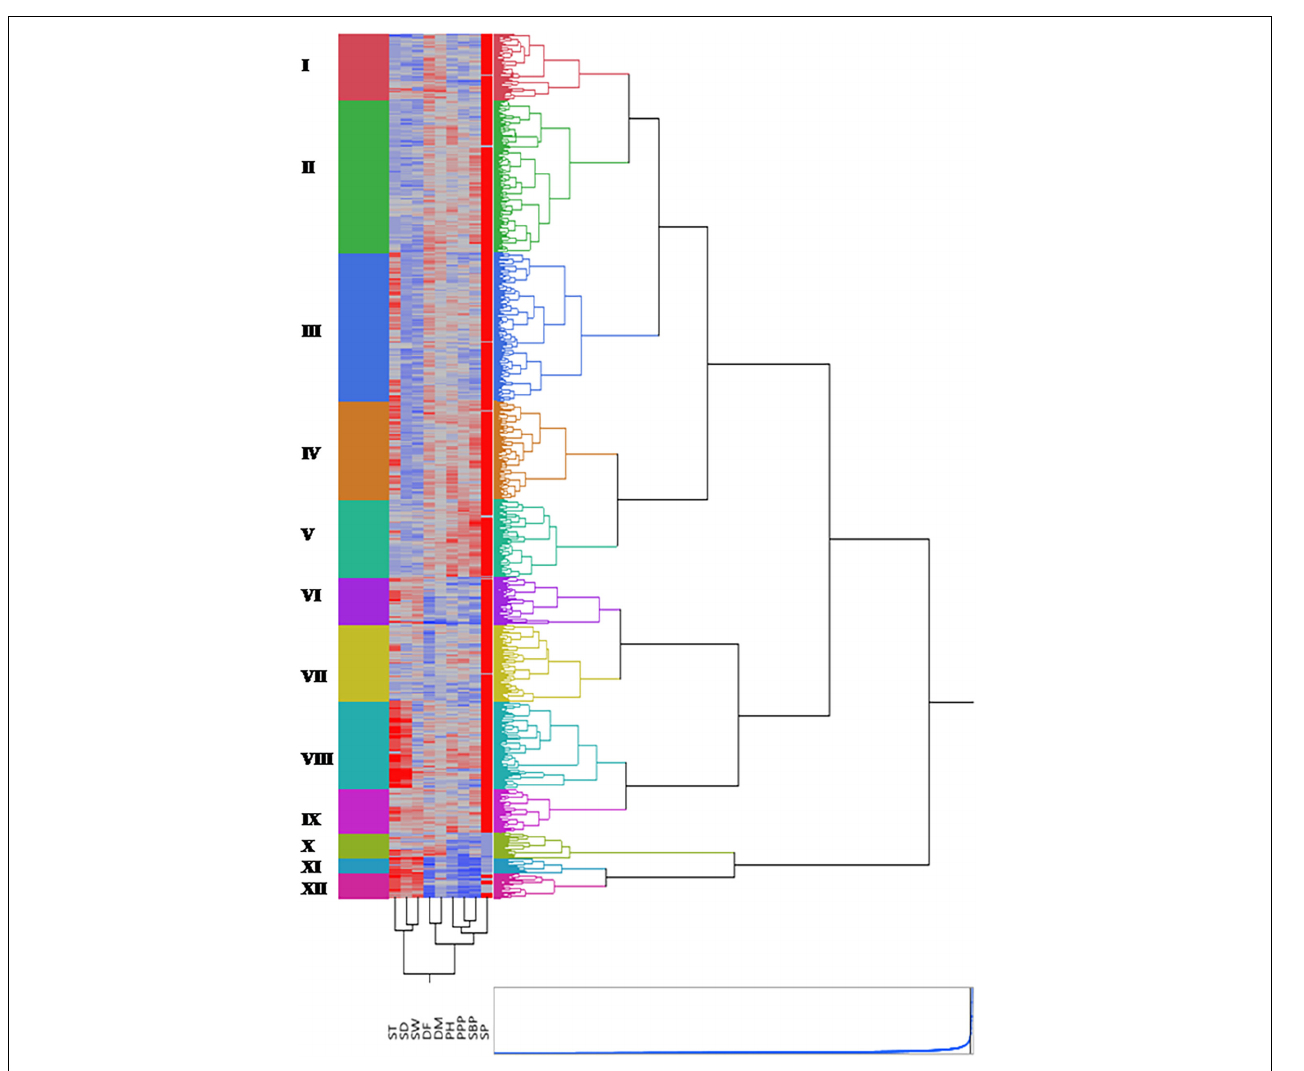
FIGURE 7 | Dendrogram along with heatmap of entire germplasm generated by performing hierarchical cluster analysis. Twelve clusters are represented by different colors. The two-dimensional heatmap is represented by columns and rows. Each column represents different quantitative trait and each row an accession. The higher the trait value, the brighter is the red and similarly, lower the trait value, brighter is the blue color,